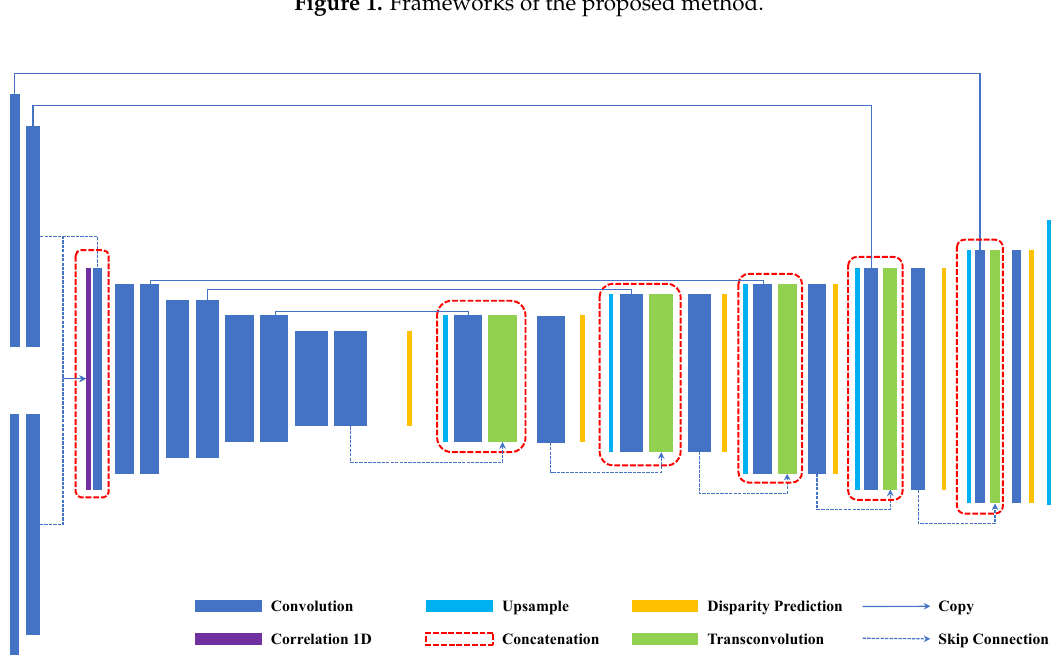
Figure 2. Architecture of